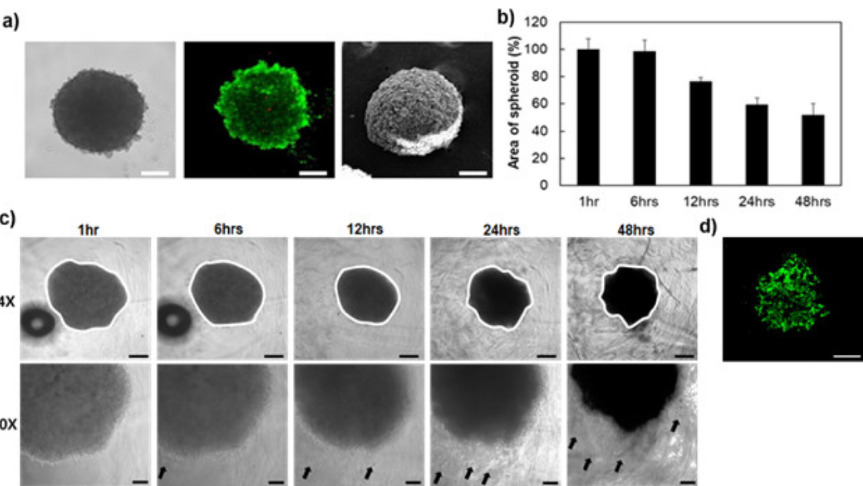
Figure 6. ( a ) The images of spherical assembly of AM using an inverted microscope, Live/Dead assay, and SEM. Cell behavior was measured ( b ) the spheroid area by Image J and ( c ) an inverted microscope at 1, 6, 12, 24, 48 h. ( d ) Live/Dead image of the spheroid at 48 h. The scale bar is 500 µ m (4 × ) and 50 µ m (10 × ),